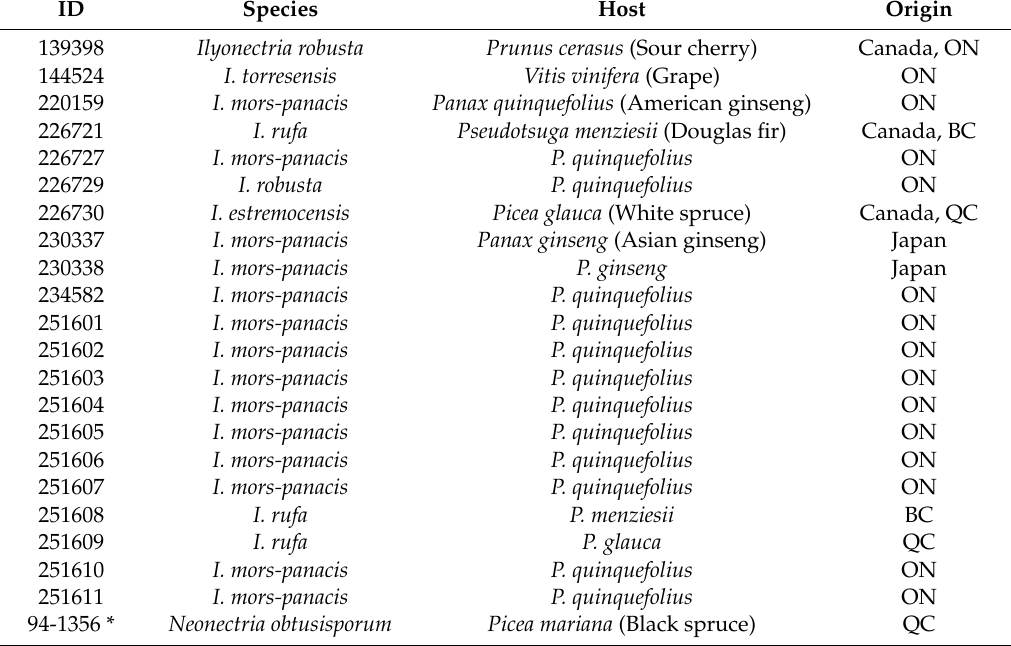
Table 2. Isolates of Ilyonectria and Neonectria spp. used in this study. All cultures except (*) were received from the Canadian Collection of Fungal Cultures (DAOMC). (*) is not deposited in the DAOMC at the time of writing and is from the laboratory collection of